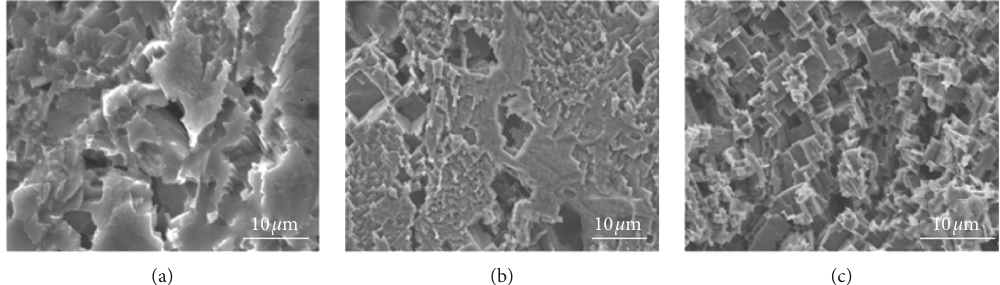
Figure 8: FESEM images of the Al alloy surfaces etching with different H